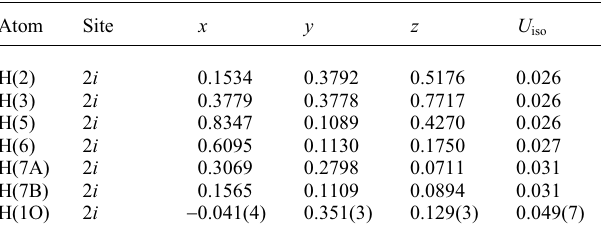
Table 2. Atomic coordinates and displacement parameters (in Å 2 )